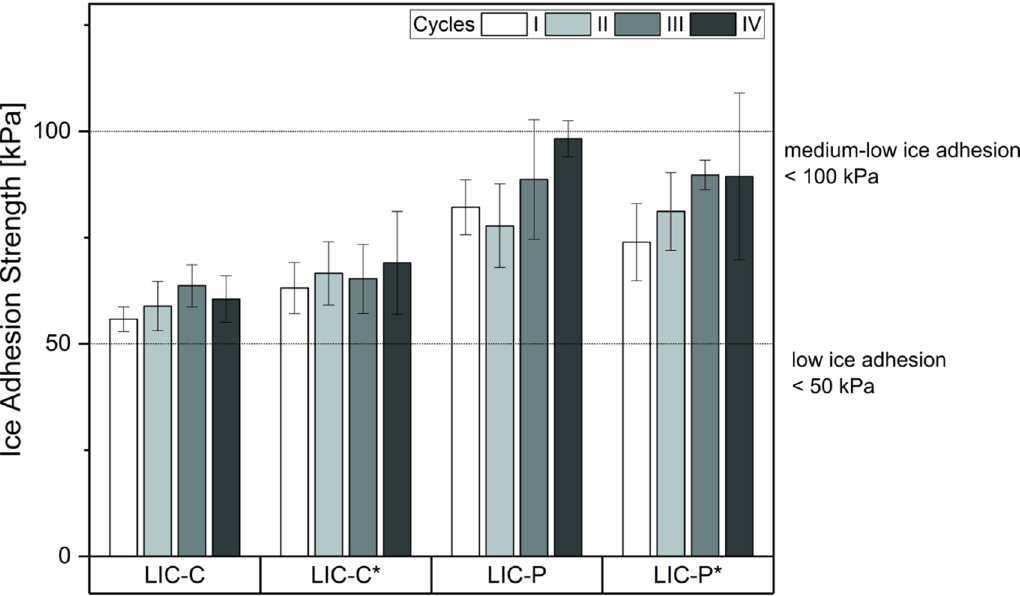
Figure 7. Ice adhesion results for lubricated icephobic coatings (LICs) under four icing/deicing cycles. Ice adhesion strength values at the first cycle were previously reported in Figure 6. C and P refer to fully hydrogenated cottonseed oil and paraffinic wax additives, respectively. The asterisk indicates the post-heating treatment by flame.